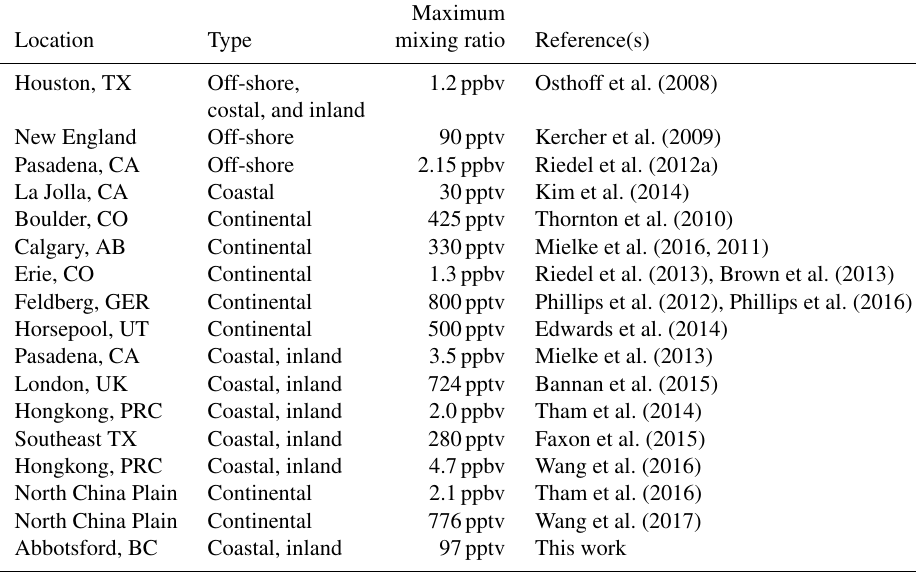
Table 3. Maximum ClNO 2 mixing ratios observed to